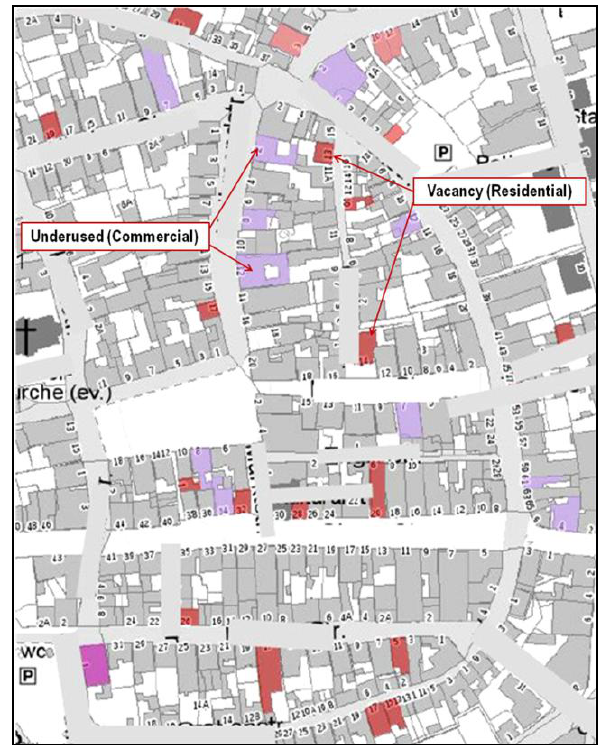
Figure 6: Example of an inventory on vacancy (LGLN